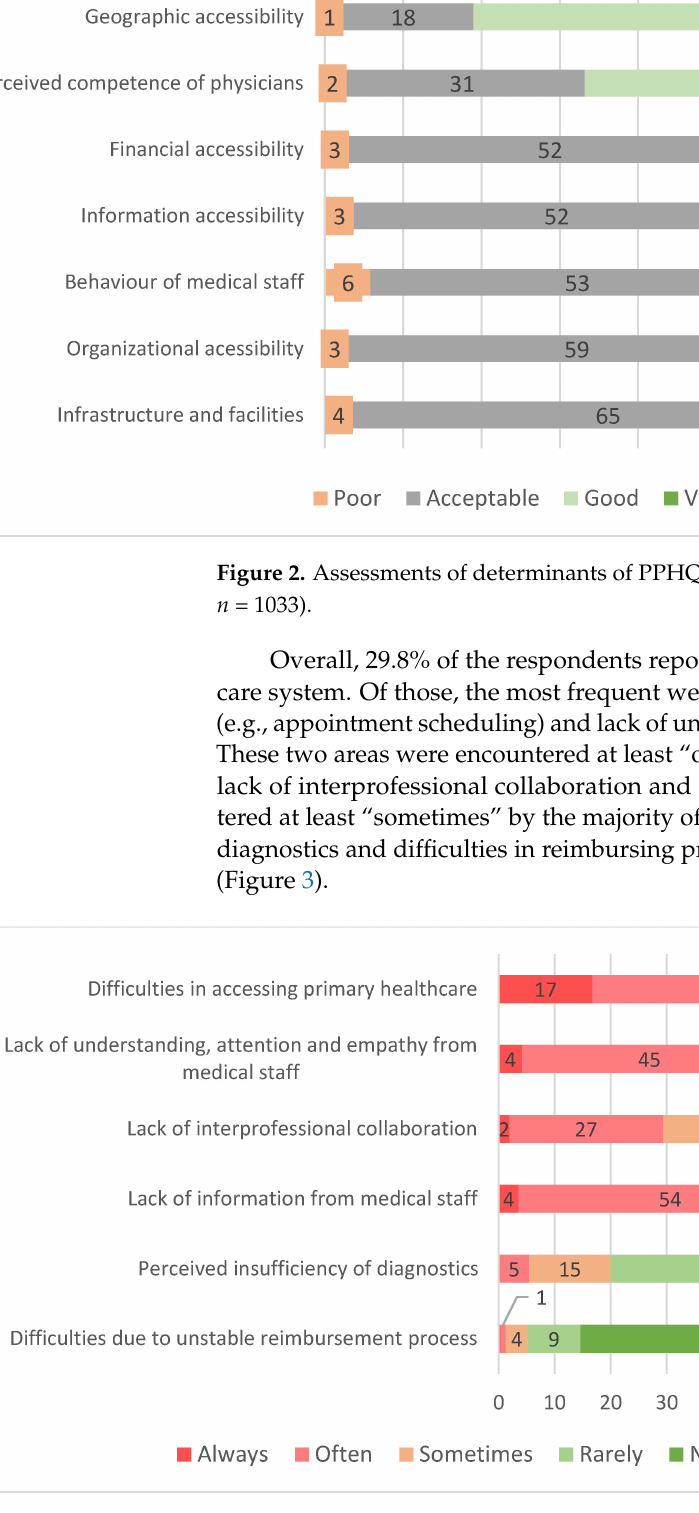
Figure 3. Frequency (based on experience) of patients encountering problems (in percent of respon- dents, who reported having experienced difficulties, n =